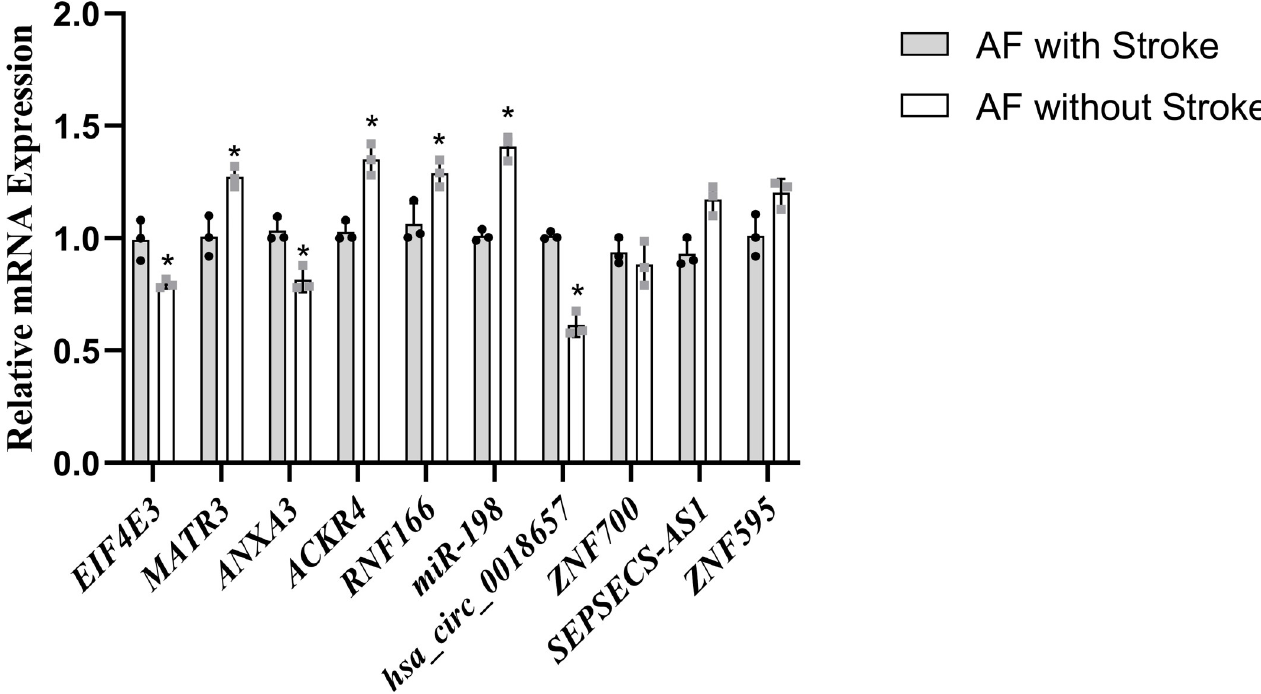
Fig 9. The expression levels of 8 hub genes, miR-198, and hsa_circ_0018657 (n = 3). � : P < 0 . 05 .